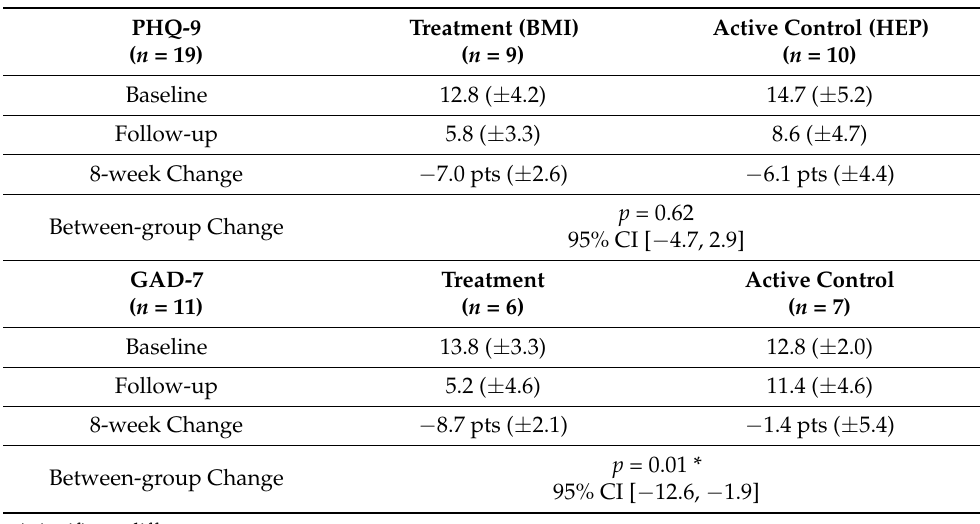
Table 2. Primary analyses of primary and secondary outcomes: change in depression (PHQ-9) and anxiety (GAD-7) in participant subgroups (baseline PHQ-9 or GAD-7 ≥ 10). PHQ-9 Treatment (BMI) Active Control (HEP) ( n = 19) ( n = 9) ( n = 10) Baseline 12.8 ( ± 4.2) 14.7 ( ± 5.2) Follow-up 5.8 ( ± 3.3) 8.6 ( ± 4.7) 8-week Change − 7.0 pts ( ± 2.6) − 6.1 pts ( ± 4.4) p = 0.62 Between-group Change 95% CI [ − 4.7, 2.9] GAD-7 Treatment Active Control ( n = 11) ( n = 6) ( n = 7) Baseline 13.8 ( ± 3.3) 12.8 ( ± 2.0) Follow-up 5.2 ( ± 4.6) 11.4 ( ± 4.6) 8-week Change − 8.7 pts ( ± 2.1) − 1.4 pts ( ± 5.4) p = 0.01 * Between-group Change 95% CI [ − 12.6, − 1.9] * significant